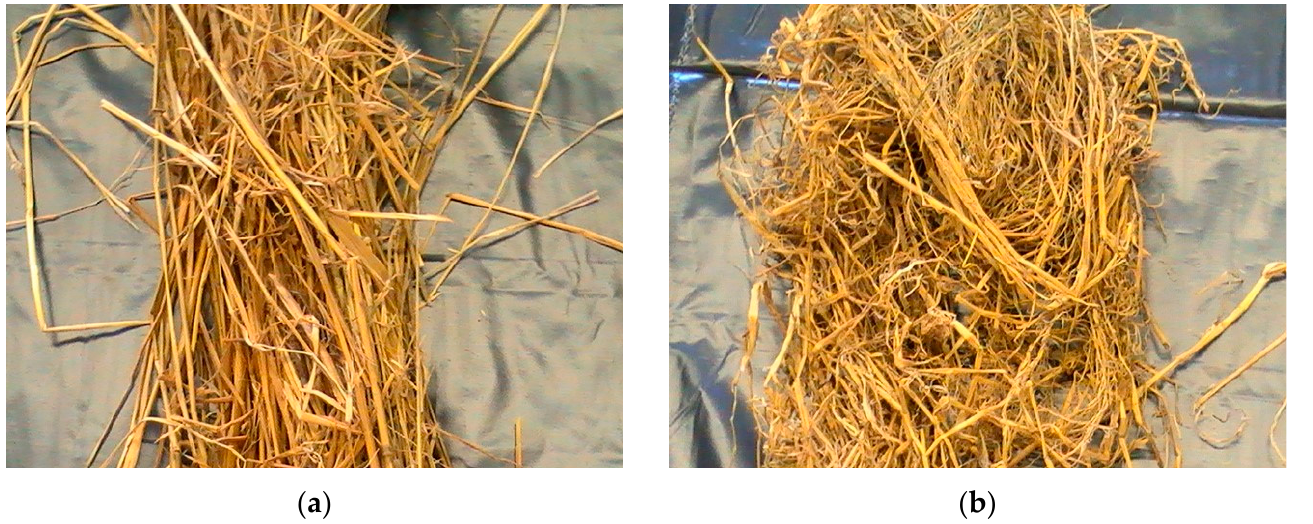
Figure 1. Local Egyptian rice straw: ( a ) untreated rice straw; ( b ) pretreated rice straw with 1% NaOH lye.